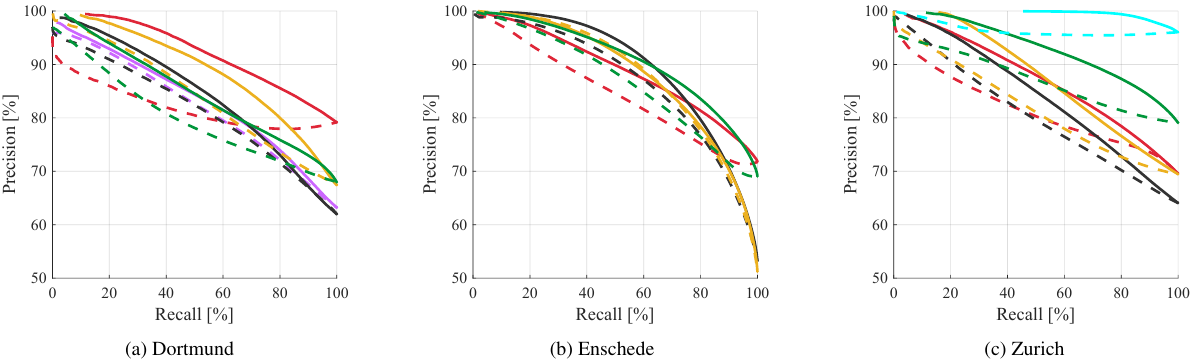
Figure 2: Cross-validated precision-recall curves of the supervised, non-semantic filtering approach (dashed lines) and the semantically informed filtering approach (solid lines). The colors indicate the semantic classes building, roof, ground, vegetation, fields, and water. separate inliers and outliers equally well as a class-specific